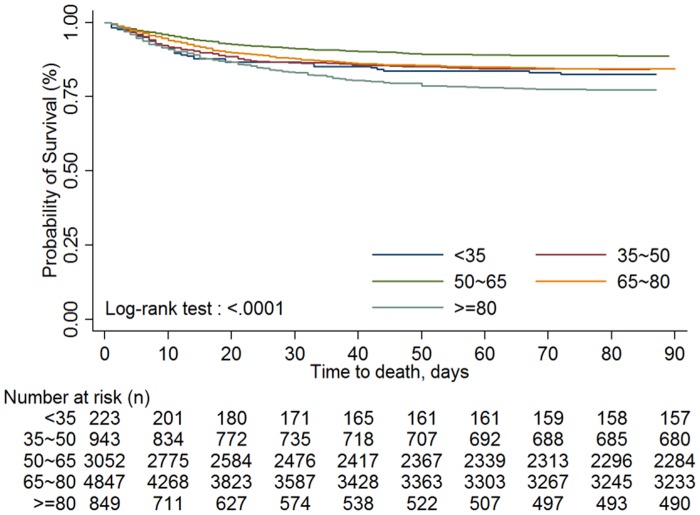
Time-to-event curves by different age groups for all-cause in-hospital mortality up to 90 days.The event rate represents Kaplan-Meier estimates; log-rank test: p < 0.0001.